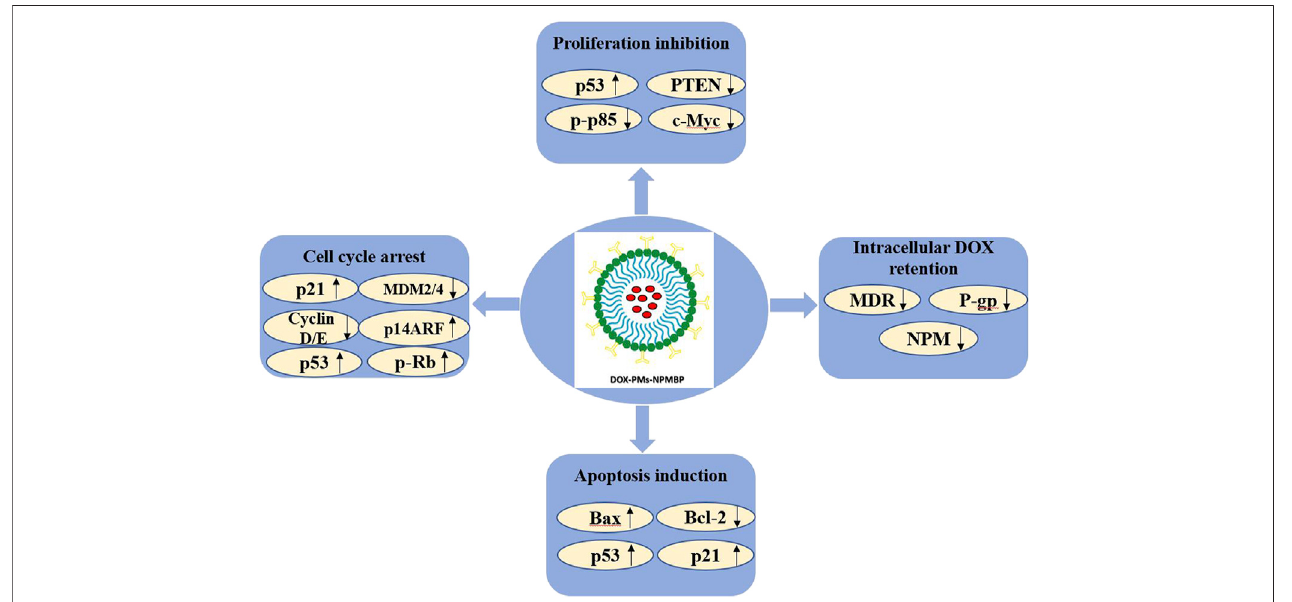
FIGURE 9 | The molecular mechanisms linking the anti-leukemia activity of DOX-PMs-NPMBP in DOX-resistant ALL cells.